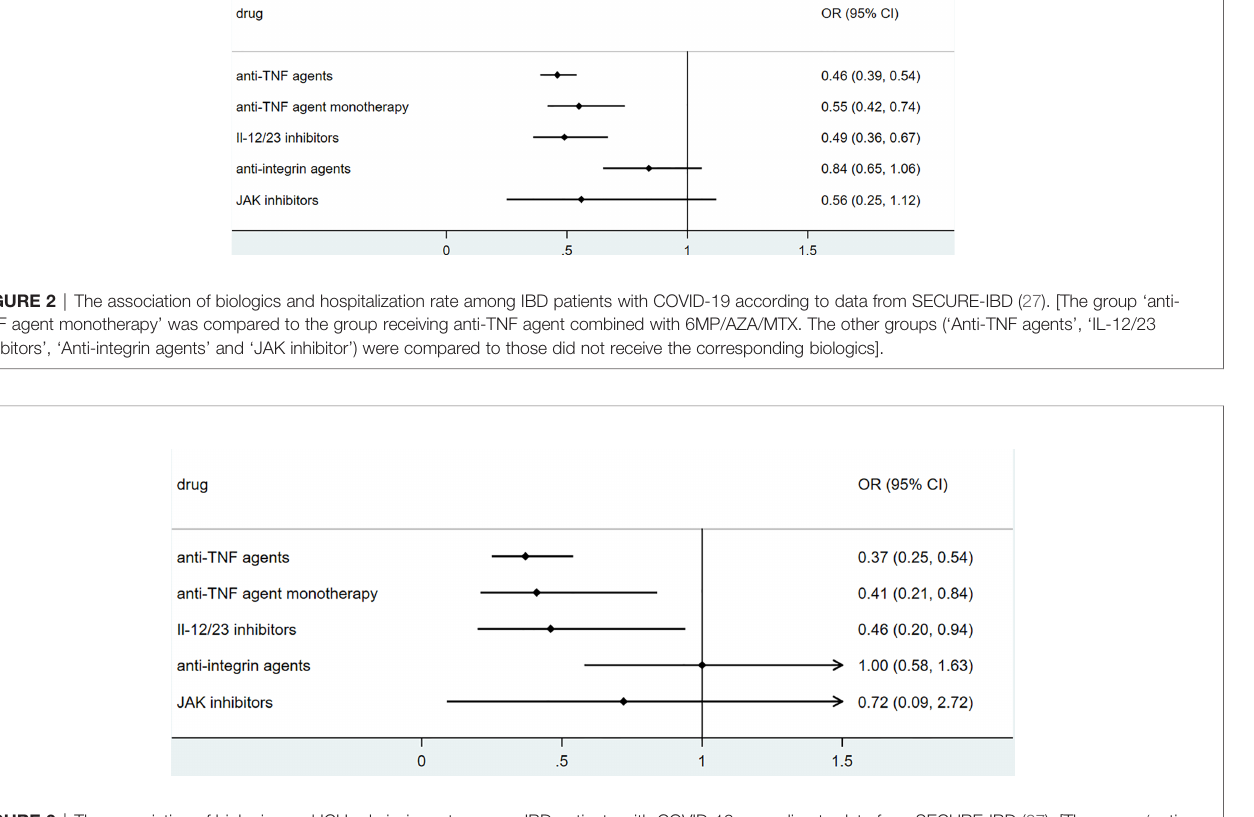
FIGURE 3 | The association of biologics and ICU admission rate among IBD patients with COVID-19 according to data from SECURE-IBD (27). [The group ‘ anti- TNF agent monotherapy ’ was compared to the group receiving anti-TNF agent combined with 6MP/AZA/MTX. The other groups ( ‘ Anti-TNF agents ’ , ‘ IL-12/23 inhibitors ’ , ‘ Anti-integrin agents ’ and ‘ JAK inhibitor ’ ) were compared to those did not receive the corresponding biologics].